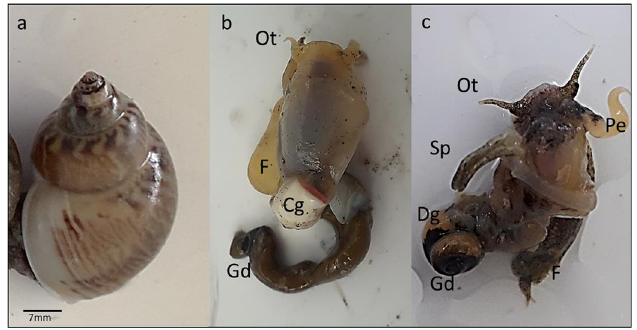
Fig. 2. T. mutabilis . (a) Whole specimen with its shell. (b) Anatomical details of a female. (c) Anatomical details of a male. Cg Capsule gland, Dg Digestive gland, F Foot, Gd Gonad, Ot Ocular tentacle, Pe Penis, Sp